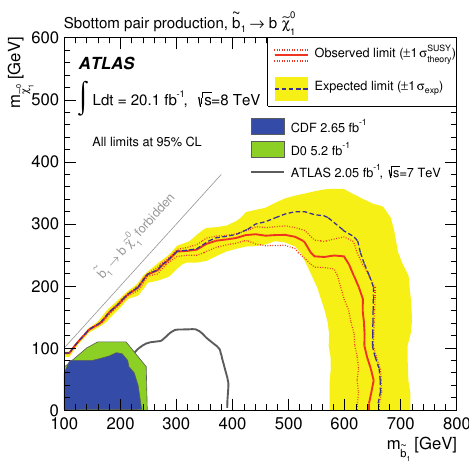
Figure 2: Expected and observed exclusion lim- its at 95% CL in the ( m ˜ , m ) mass plane for ˜ χ 0 1 b 1 the sbottom pair production scenario consid- ered. The signal region providing the best ex- pected CLs exclusion limit is chosen at each point. The dashed (solid) lines show the ex- pected (observed) limits, including all uncer- tainties except for the theoretical signal cross- section uncertainty (PDF and scale). The bands around the expected limits show the ± 1 σ un- certainties. The dotted lines around the ob- served limits represent the results obtained when moving the nominal signal cross sec- tion up or down by the ± 1 σ theoretical uncer- tainty.